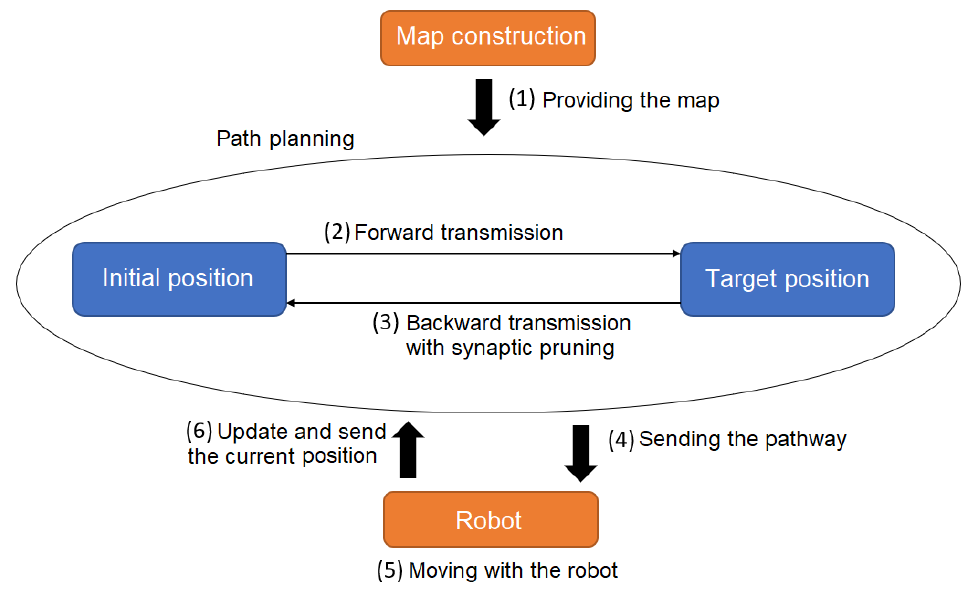
Figure 13. The path-planning